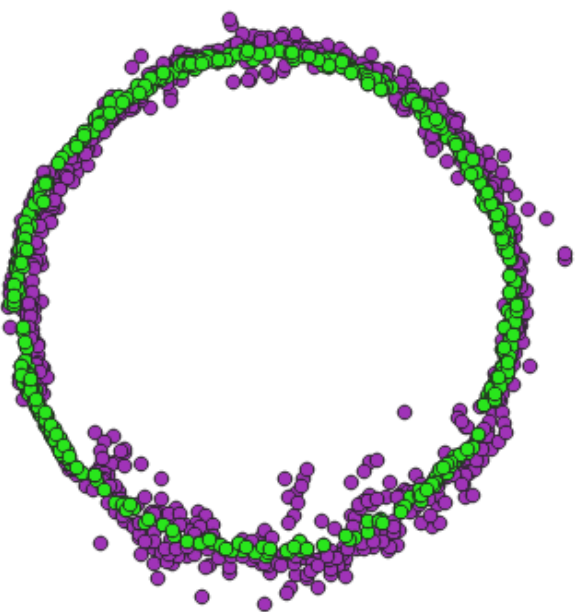
Figure 11. Points from the RTK measurement ( purple ) and the fitted reference circle ( green ).